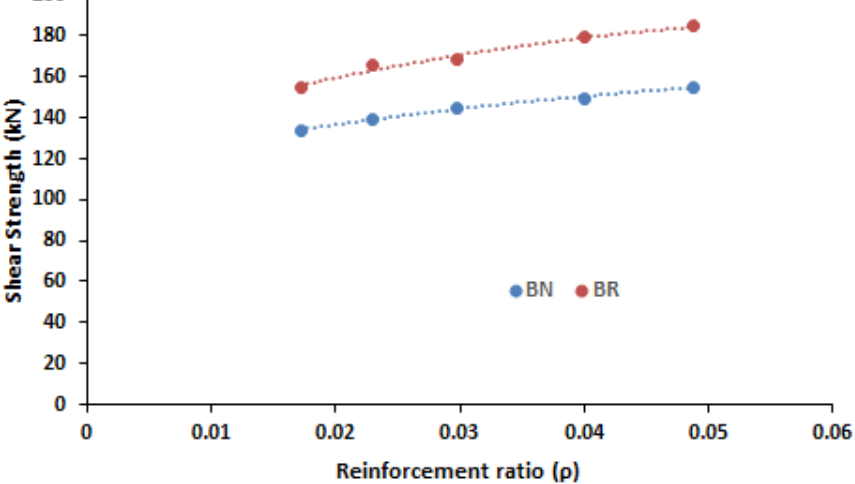
Figure 11. Influence of UPR mortar on shear strength of RC beam at various reinforcement ratios (numerical simulation).